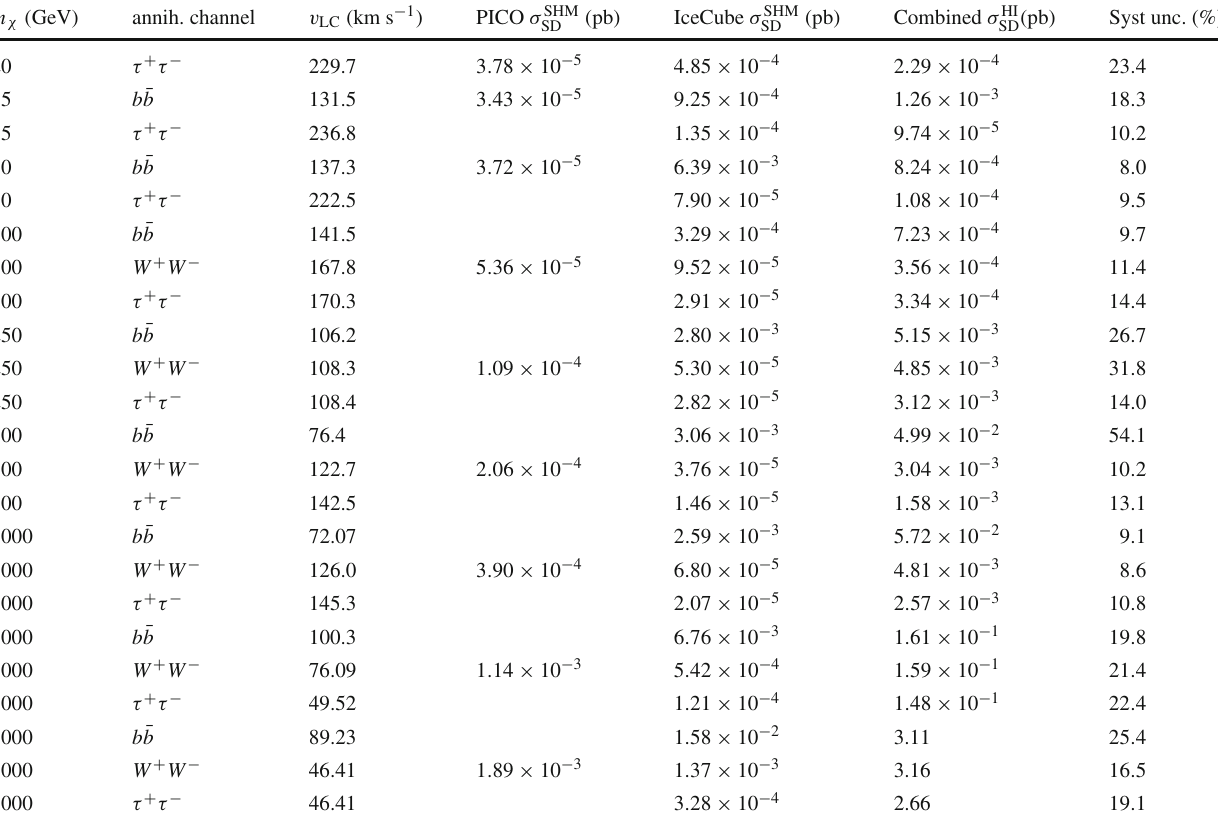
Table 1 Constraints on the SD DM-nucleon cross-section. SHM con- straints from PICO and IceCube, as well as the DM velocitydistribution independent constraint are presented at (cid:3) 90% CL. The velocity of DM